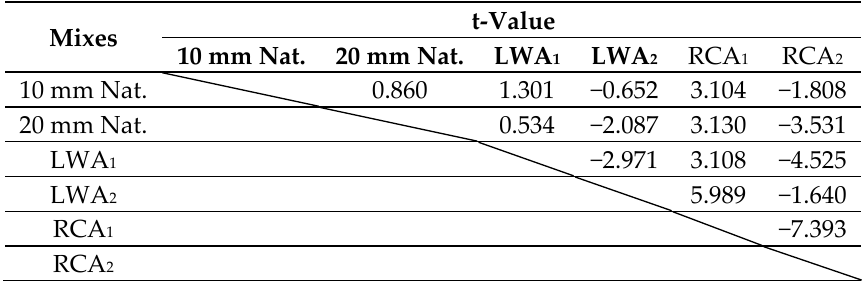
Table 10. Summary of hypothesis testing results for Cy / Cu at 90-day.